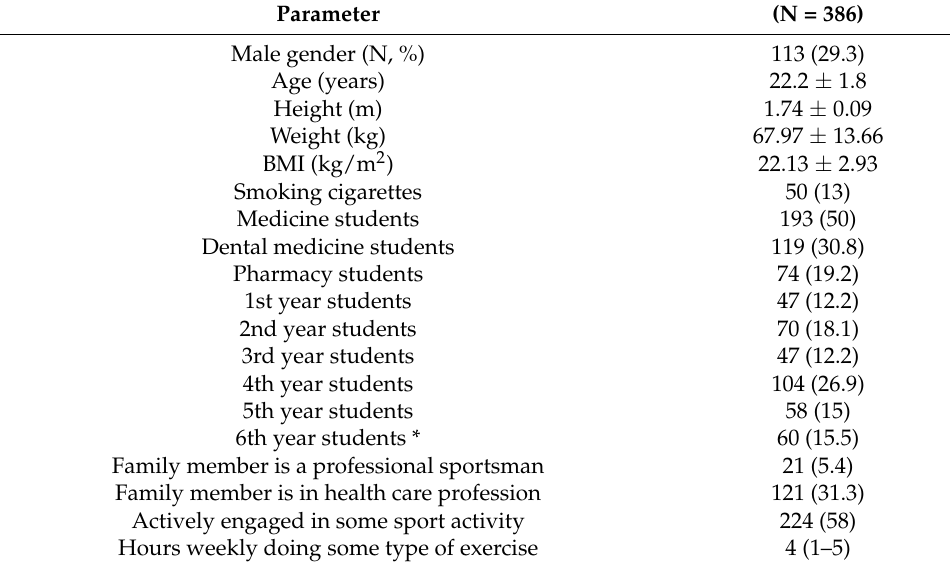
Table 1. Baseline characteristics of the study